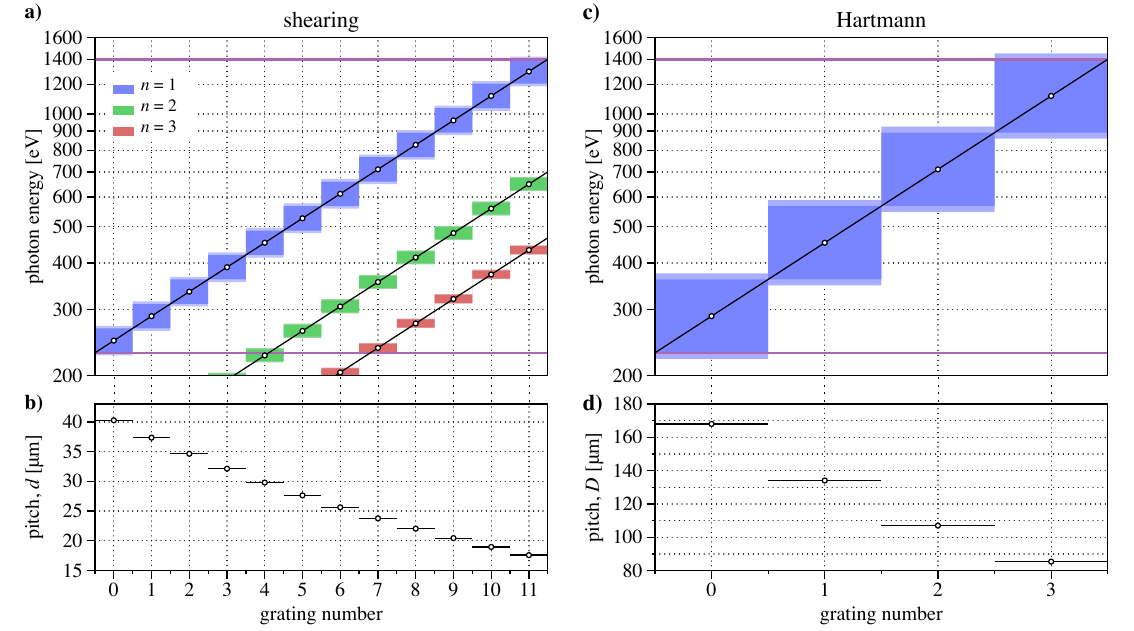
Figure 7. Design of shearing and Hartmann arrays spanning a 230eV to 1400eV energy range. ( a ) Counting 0 to 11, twelve gratings span the range with β = 0.1624, using the first Talbot plane ( n = 1). Blue-colored regions show the individual gratings’ operating energy range. The equivalent energy range is shown for the second and third Talbot planes in green and red. ( b ) Corresponding grating pitch values. ( c ) With β = 0.4351, four Hartmann grids (Numbered 0 to 3) span the range. ( d ) Corresponding Hartmann grid pitch